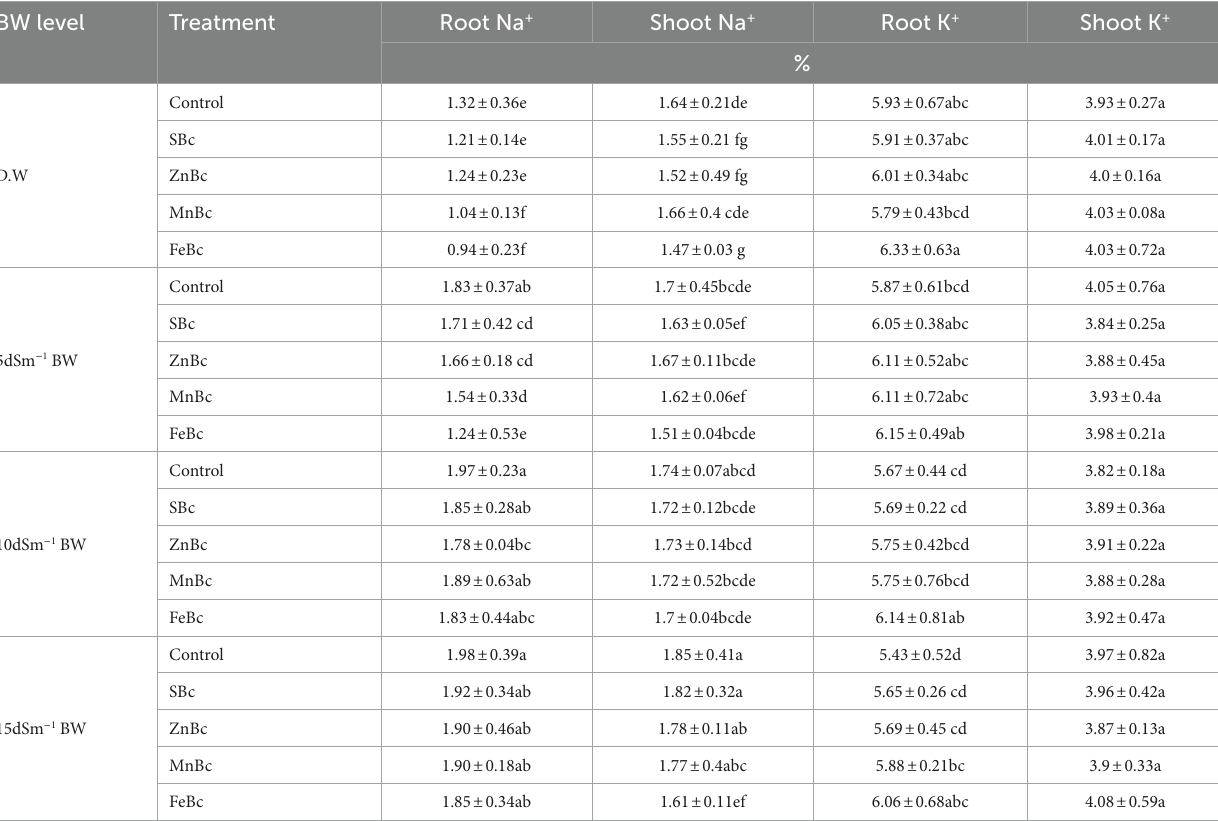
TABLE 3 Sodium (Na + ) and potassium (K + ) concentrations in root and shoot of T. aestivum L. reported with different levels of distilled water (D.W), brackish water (BW), and rice husk biochars such as simple biochar (SBc), zinc biochar (ZnBc), manganese biochar (MnBc), and iron biochar (FeBc) in a pot